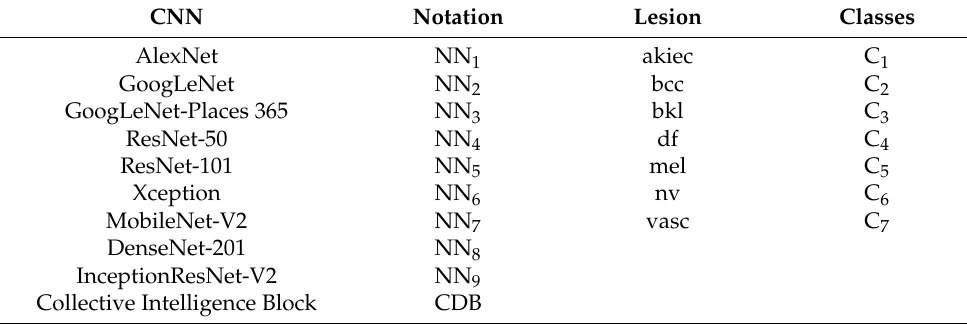
Table 1. Notations for the neural networks and lesion classes used.